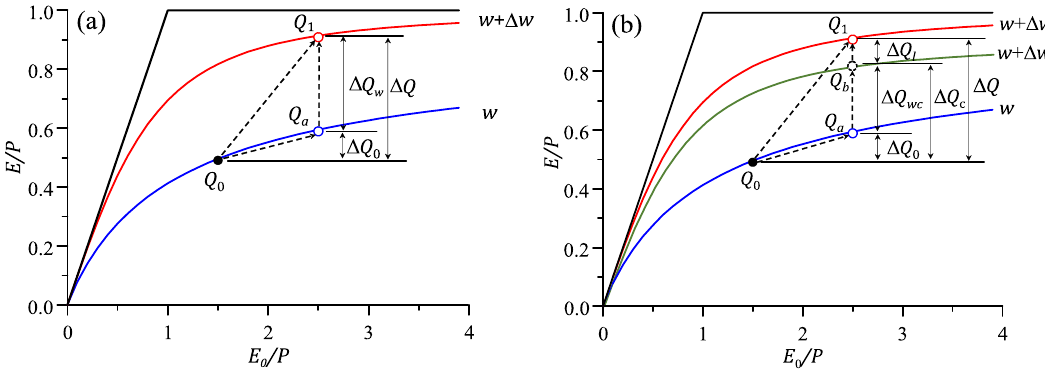
Figure 3. Partition of discharge change in the Budyko framework. ( a ) The traditional separation approach: discharge change (Δ Q ) is primarily separated into two components, Δ Q 0 and Δ Q w . ( b ) The approach: discharge change ( ∆ Q ) is primarily separated into two components, ∆ Q 0 and ∆ Q w . ( b ) The modified separation approach: Δ Q w is further separated into Δ Q wc and Δ Q l in considering the impacts modified separation approach: ∆ Q w is further separated into ∆ Q wc and ∆ Q l in considering the impacts of climate change and frozen‐ground degradation on the catchment‐specific parameter. of climate change and frozen-ground degradation on the catchment-specific